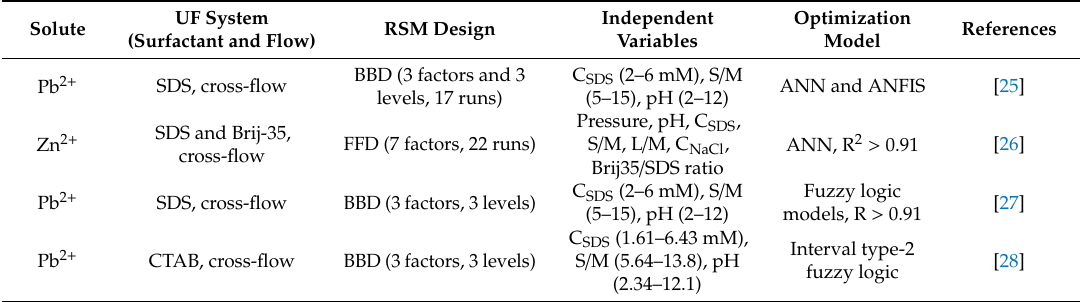
Table 1. Summary of MEUF studies integrating RSM and other optimization